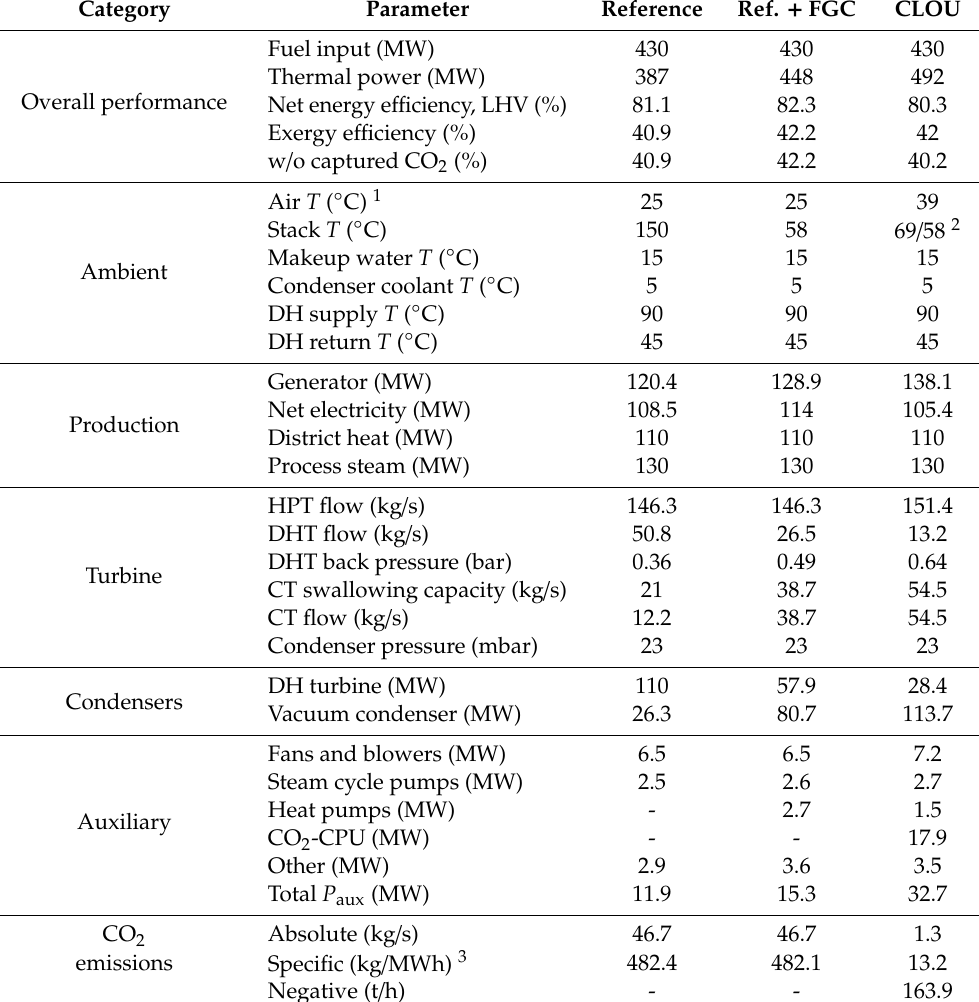
Table 3. Main performance figures of the reference CHP plant and the CLOU